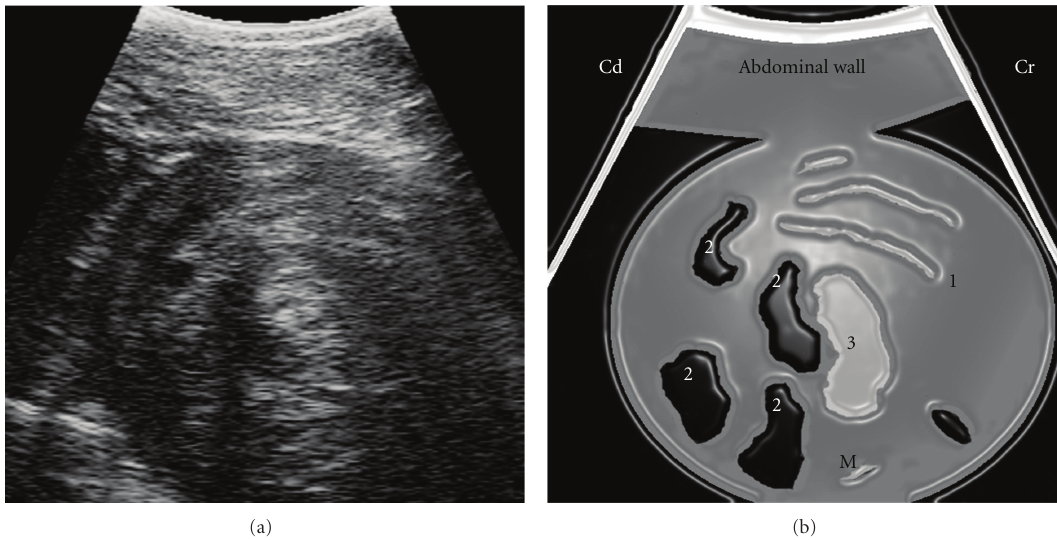
Figure 1: Ultrasonogram of the uterine tumour, imaged from the right paralumbar fossa, after bringing it closer to the abdominal wall by transrectal manipulation and placing the transducer parallel to the longitudinal axis of the cow. 1: uterine tumour, 2: hypoechogenic areas, 3: echogenic areas, Cd: caudal, Cr: cranial, and M: medial.